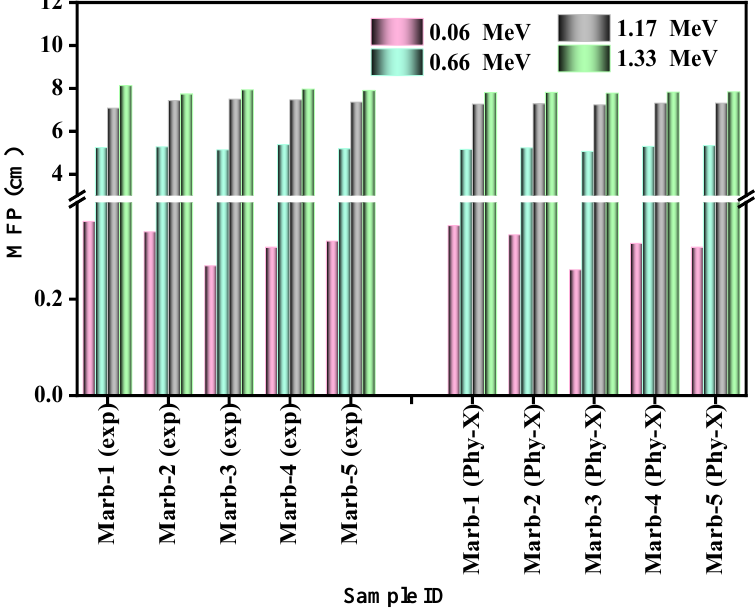
Figure 8. The comparison between the experimental and theoretical values of the MFP of the prepared composites.